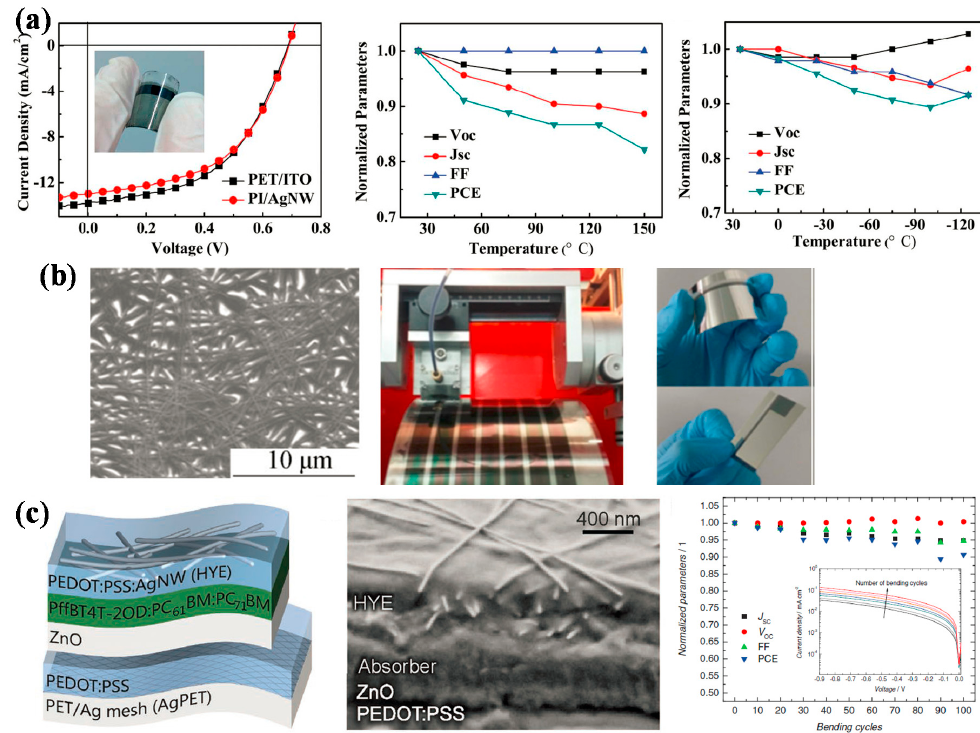
Figure 8. ( a ) J–V characteristics and normalized parameters of PI/Ag NWs based device during heating and cooling. Reproduced from [70] with permission of The Royal Society of Chemistry. ( b ) SEM of Ag NWs coated on PET substrate, fabrication of active layer in R2R process and flexible polymer solar cell with large-area (7 cm 2 ). Reproduced with permission from [76]; published by Springer, 2016. ( c ) Device architecture, cross-sectional SEM image and evolution of the key performance parameters of the flexible polymer solar cell (>1 cm 2 ) versus number of bending cycles. Reproduced with permission from [77]; published by John Wiley and Sons,